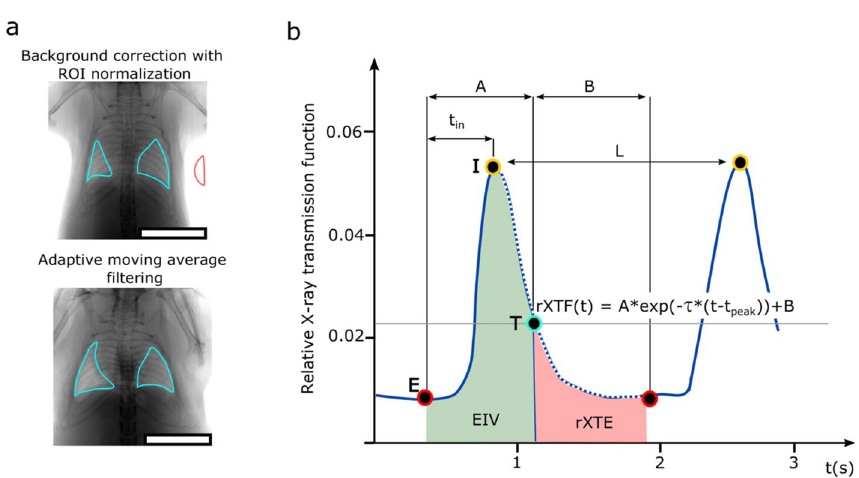
Figure 5. Quantification of advanced XLF parameters from the X-ray transmission over time. ( a ) A representative radiograph is shown, demonstrating background correction based on the selection of ROI at the lung lobes marked in cyan normalized by selection of the background marked in red (top panel). The modified background correction at ROI is accomplished by applying an adaptive moving average filter which requires a smaller FOV (bottom panel). ( b ) Two exemplary breathing cycles extracted from the averaged X-ray transmission at the ROI are shown for a healthy mouse over a period of 3 s. The peak intensities representing maximum inhalation I are marked by yellow circles while the red circles represent the beginning of a new breathing event and the maximum exhalation phase E of the breathing cycle. The breathing curve is split at threshold T (marked by a cyan circle and a grey horizontal line) to obtain a breathing (A) and a passive expiration (B) phase. XLF parameters are shown including average inhalation time (t in ), average breathing length (L), X-ray-based end-inspiration volume (EIV [XLF] ), relative X-ray transmission at end-expiration (rXTE) and exponential function (τ, calculated in region indicated by blue dotted line). Scale bars in ( a ) represent 1